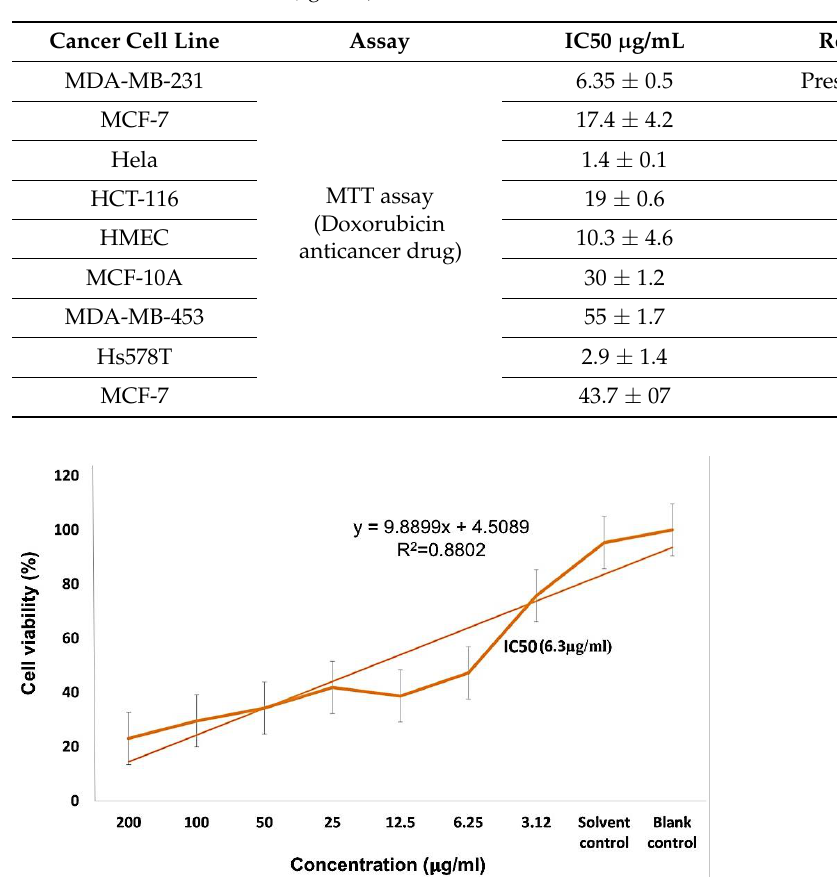
Table 2. Comparative analysis of (IC50) value in MTT assay on MDA-MB231 cancer cell line (different cancer cell line values are in µ g/mL).